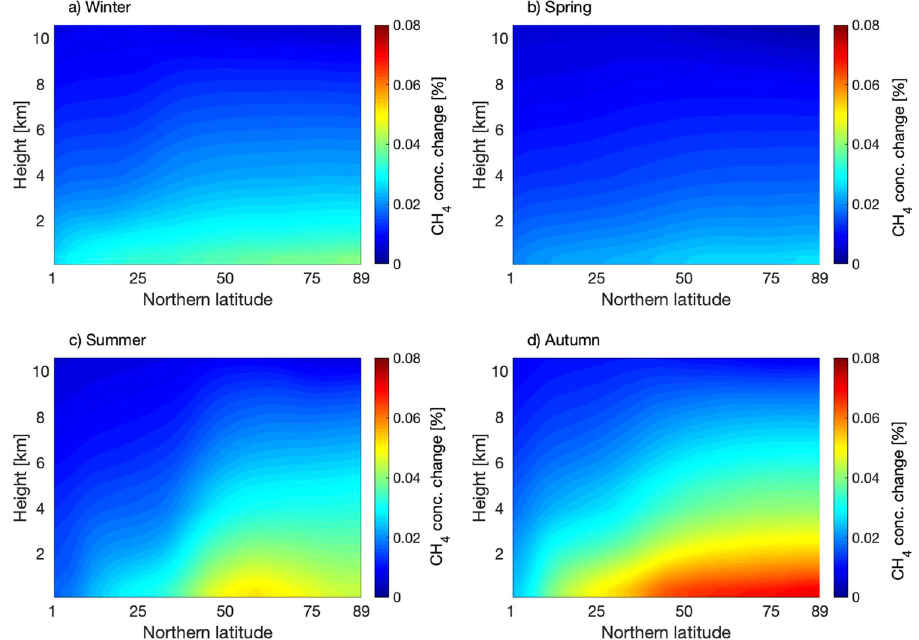
Fig. 5 Methane seasonal change in the Northern hemisphere. a – d The percentage change of methane between scenario E6C6 and E0C6 relative to the mean value of E0C6 at each latitude for the four seasons calculated with TM5 model (winter = December to February;